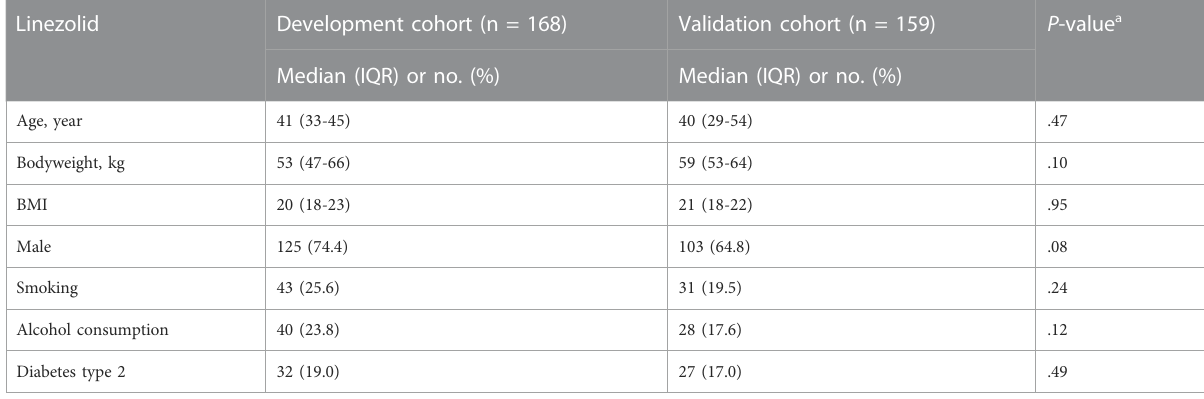
TABLE 1 Baseline demographic and clinical characteristics of participants in two studied cohorts. Linezolid